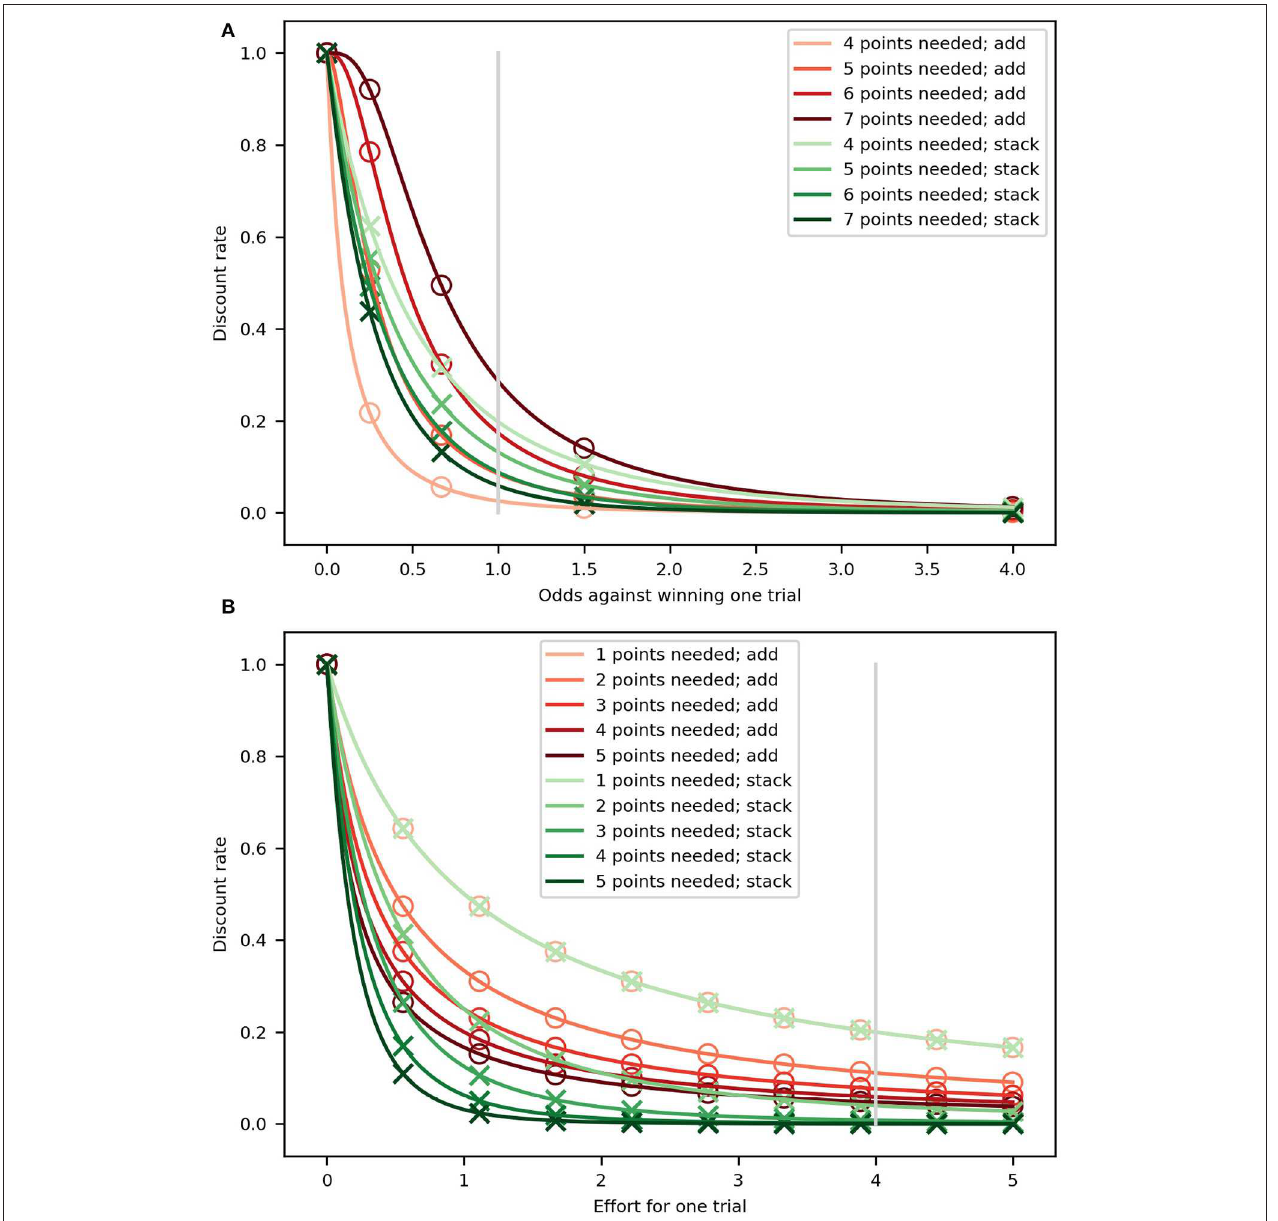
FIGURE 2 | Hyperbolic discount curves for the “add” (brown tones) and “stack” (green tones). Markers (circles and crosses) are placed at regular intervals (in probability and effort) only so that it is clear when two lines are overlapping. (A) Probability discounting. Each curve represents a probability discount curve for a number of needed points for the two variants. The parameter κ p was set to 1 and 5, for the “add” and “stack” variants, respectively. The different values were used so the curves would be as similar as possible. The gray, vertical line represents the 0.5 probability of getting a point used in the experiment. (B) Effort discounting. Each curve represents the effort discount curve for the number of needed points for the “add” (brown tones) and “stack” (green tones) variants. For both variants, the discount parameter was set to κ e = 1. The gray, vertical line represents the value used for the effort of a single effortful